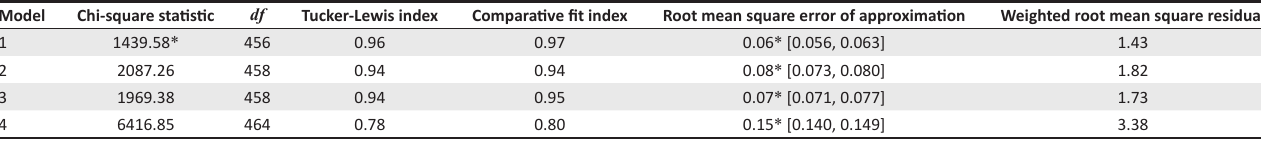
TABLE 1: Fit statistics for the hypothesised competing measurement models. Model Chi-square statistic